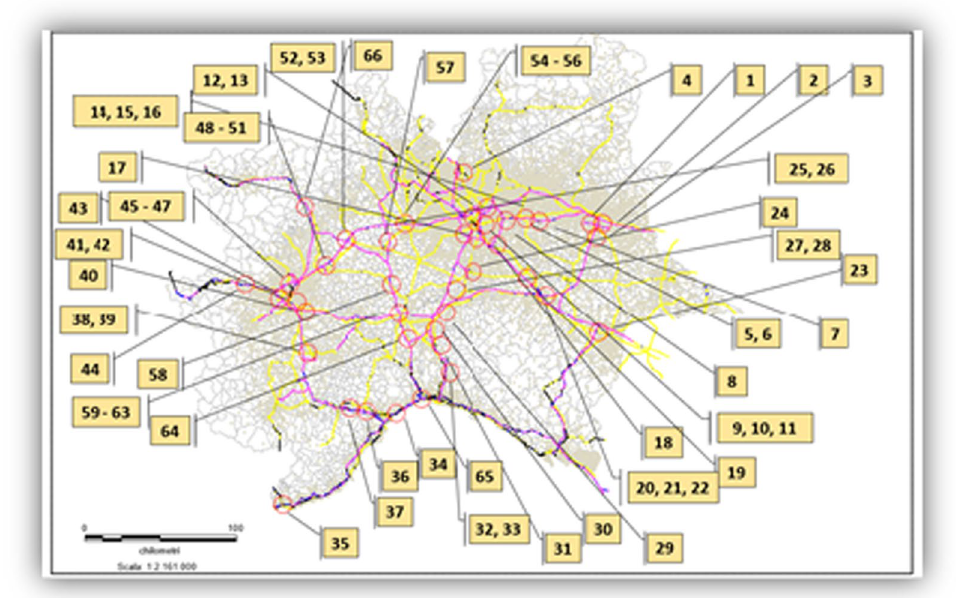
Fig. 10 Overpass points Between Motorways and Railways: Full List. Source : Authors’ elaboration in MapInfo using Openstreetmap data. Red lines indicate motorways, yellow lines indicate